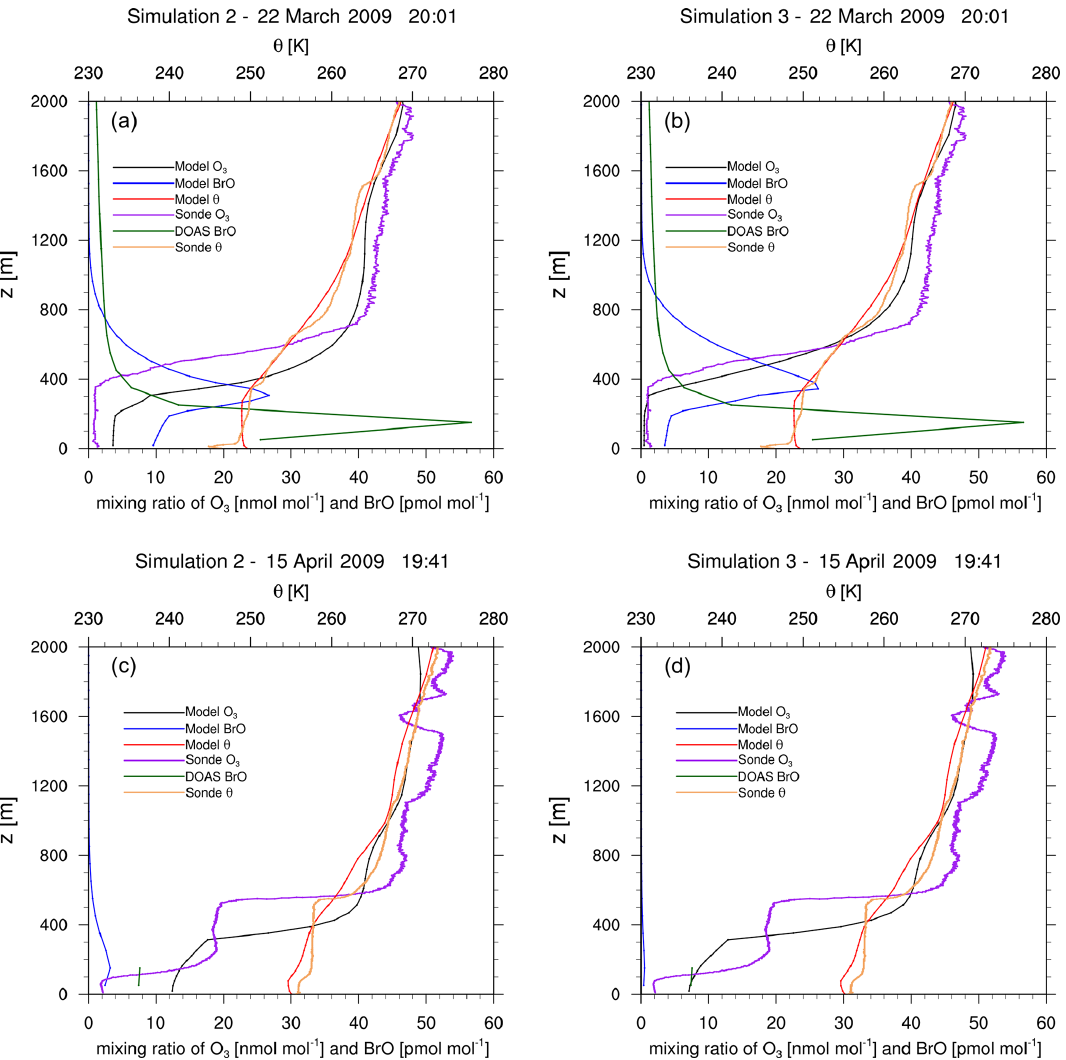
Figure 9. Vertical profiles of measured and modeled ozone (simulation 2 (a, c) and simulation 3 (b, d) , respectively), of potential tempera- ture θ , and of BrO at Utqia˙gvik on 22 March (a, b) and 15 April (b, d) 2009. The time zone is GMT + 0. Measurements are from upward flights using ozone sondes (Oltmans et al., 2012) and DOAS measurements (Frieß et al., 2011). On 15 April, only the observed BrO mixing ratio in the lowest 100m is accurate due to very poor